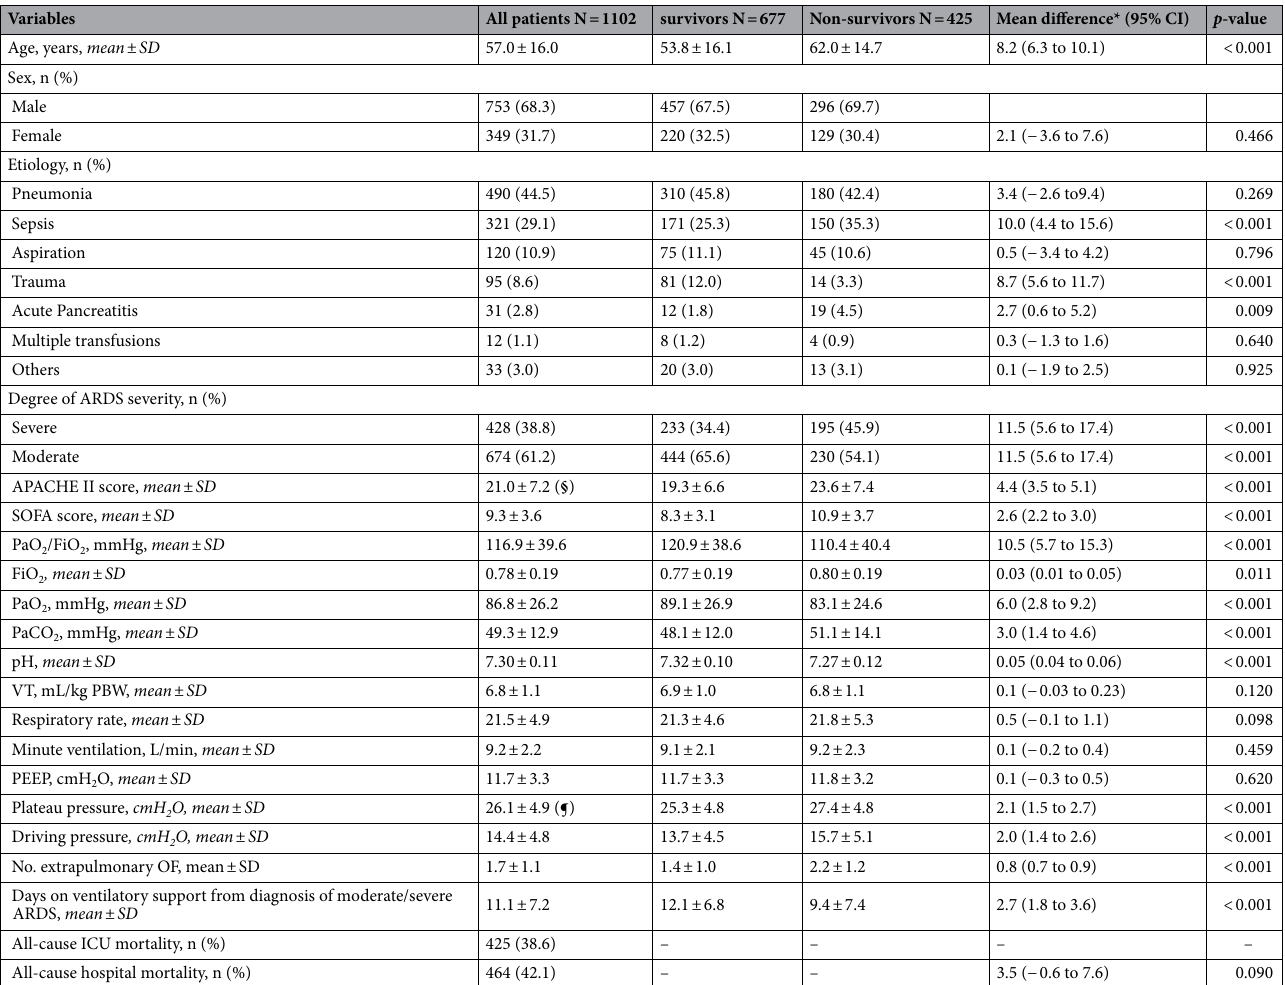
Table 3. Baseline characteristics and outcome of 1,102 patients with moderate-to-severe acute respiratory distress syndrome. Number of patients represents the cumulative number of patients on ventilatory support for ≤ 28 days and discharged dead or alive from the ICU. (*) Mean difference represents the difference between values in survivors and non-survivors. APACHE, acute physiology and chronic health evaluation; ARDS, acute respiratory distress syndrome; CI, confidence interval; FiO 2 , fraction of inspired oxygen concentration; ICU, intensive care unit; OF, organ failure; PBW, predicted body weight; PEEP, positive end-expiratory pressure; SD, standard deviation; SOFA, sequential organ failure assessment scale; VT, tidal volume. (§) APACHE II was missing in 10 survivors and 6 non-survivors. (¶) Plateau pressure was missing in 4 survivors and 6 non-